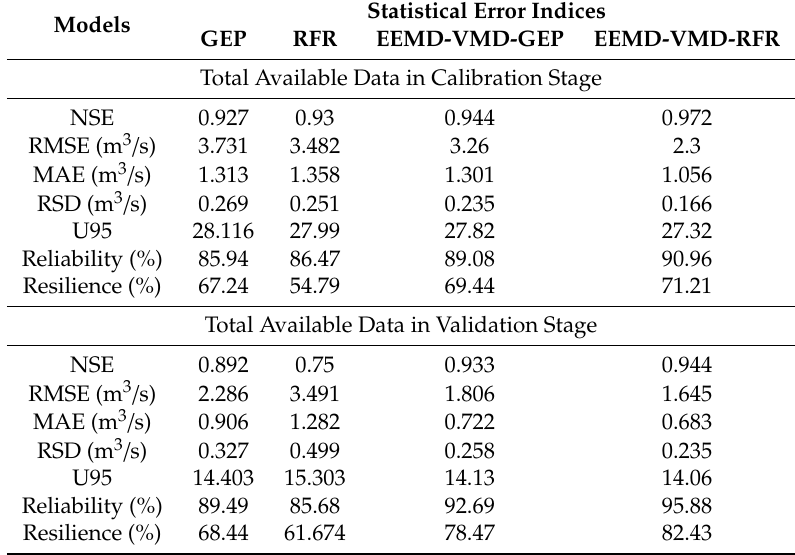
Table 5. Evaluation metrics of the proposed models in the calibration and validation periods at the Siira station.